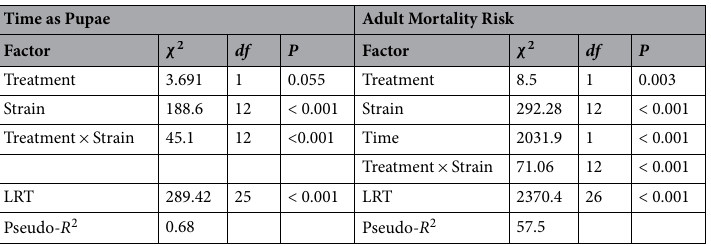
Table 2. Results of modeling time as pupae and adult mortality risk. LRT denotes likelihood ratio test. Pseudo R 2 calculated using Nagelkerke’s method 35 .